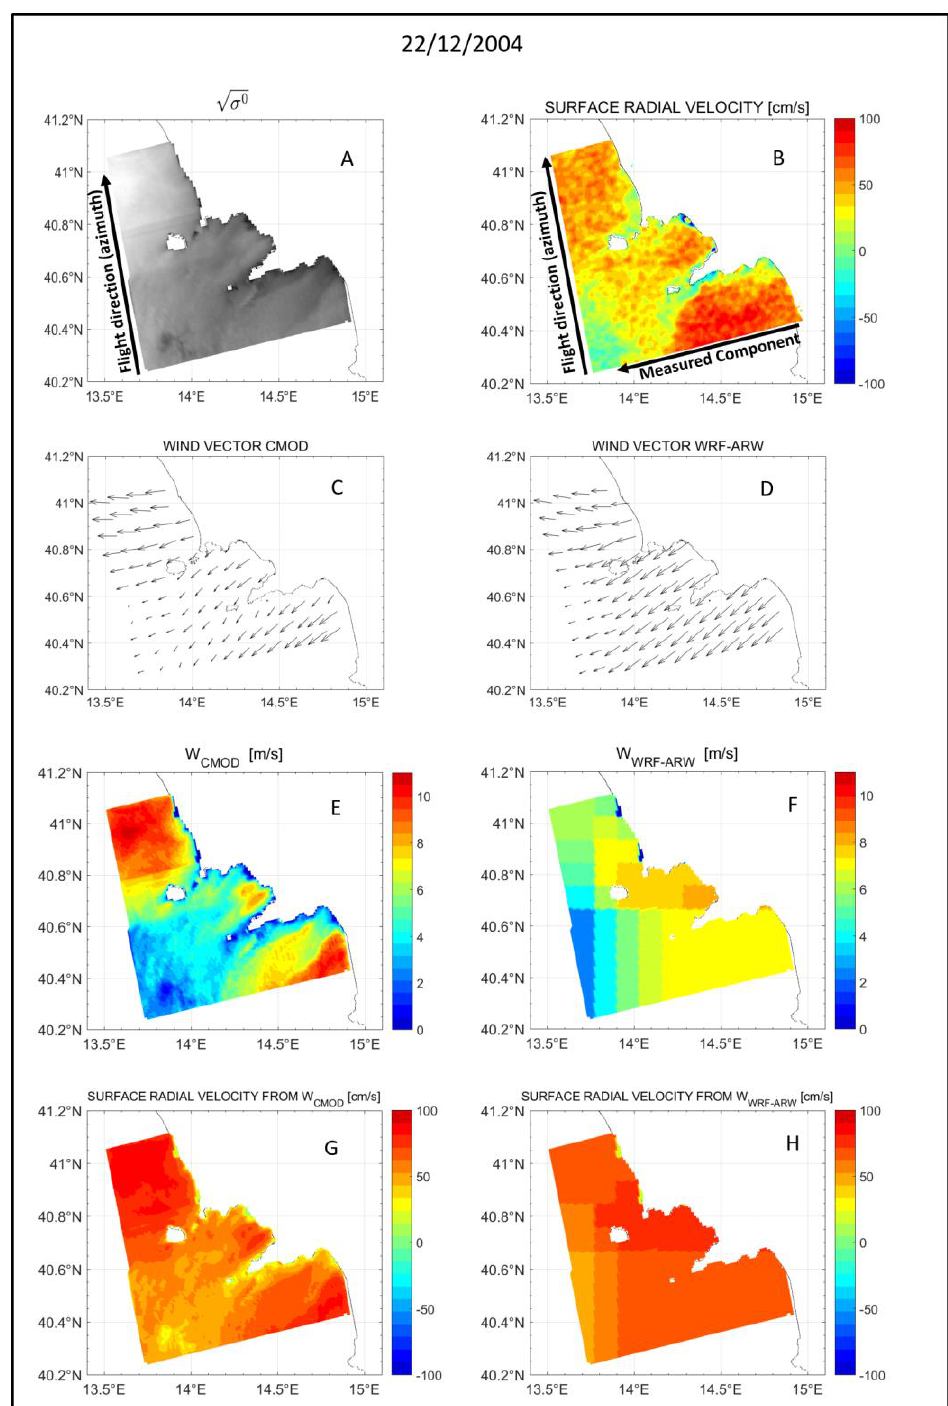
Figure 7. Results related to the acquisition of 22/12/2004. The image is divided as follow: ( A ) is the 𝜎 0 ; ( B ) is the estimated Doppler Anomaly maps of the marine area converted into the line-of-sight component of the sea surface velocity; ( C ) is the wind direction obtained from the CMOD model; ( D ) is the wind direction obtained from the WRF-ARW model; ( E ) is the wind speed relative to the CMOD model; ( F ) is the wind speed relative to the WRF-ARW model; ( G ) and ( H ) is the surface radial velocity due to the wind component, evaluated as descried in section 4, for the CMOD model and for the WRF-ARW model, respectively.